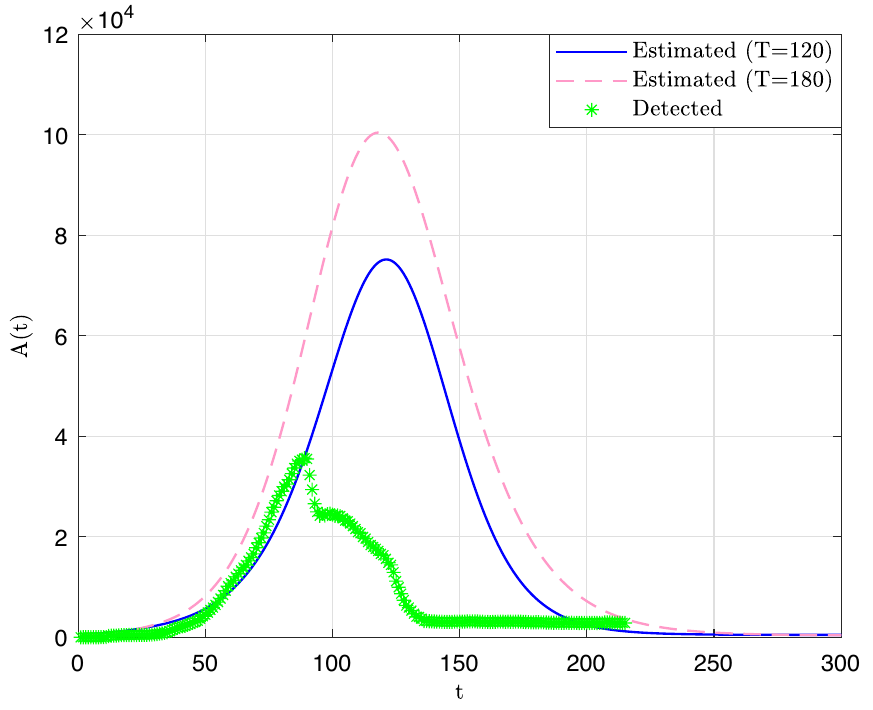
Figure 4. Estimate daily number of active cases